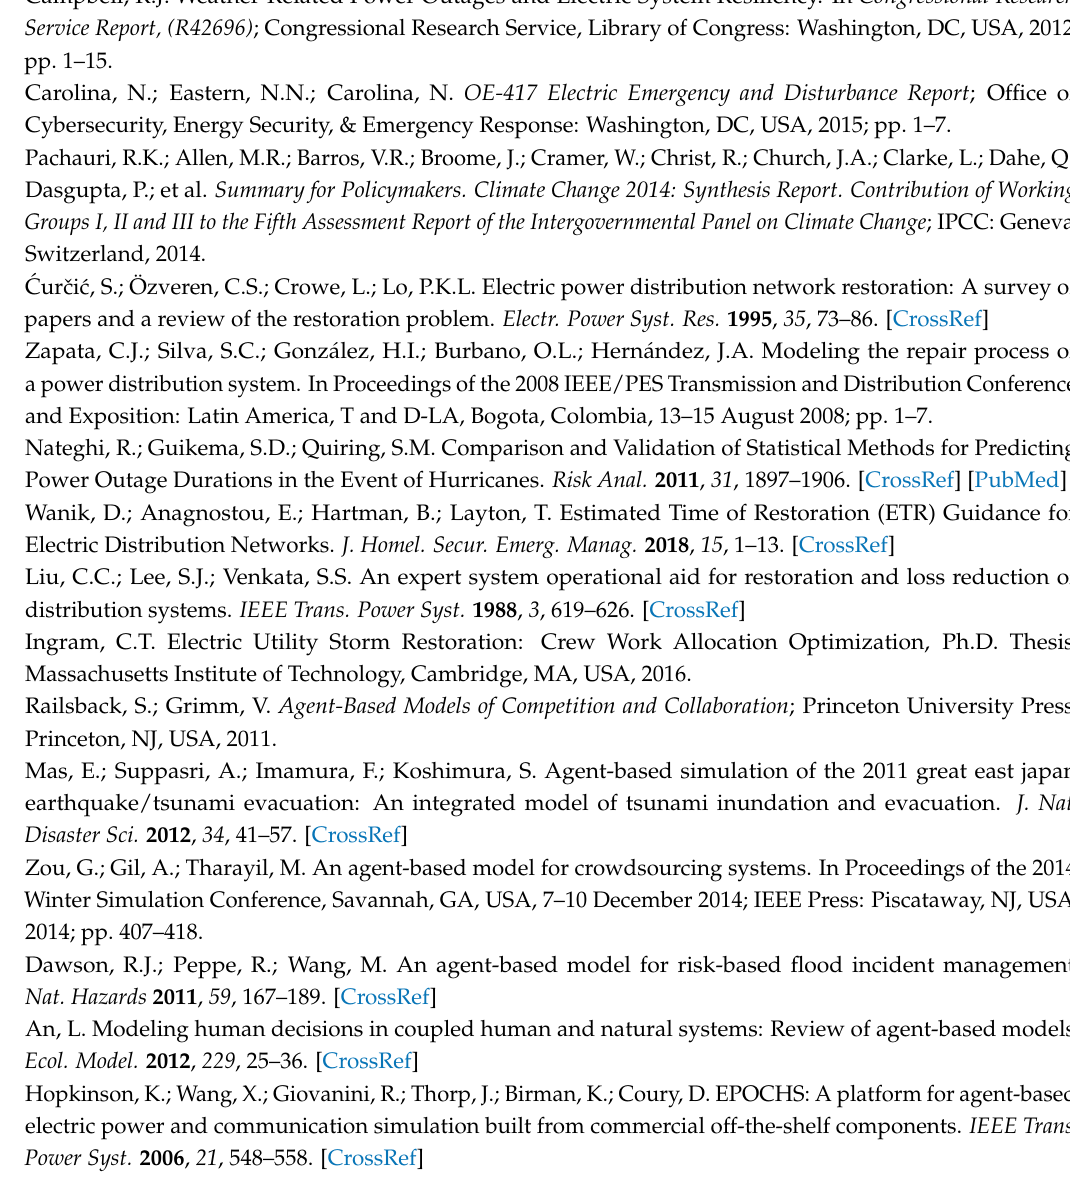
Table S1: R 2 , MAE and standard deviation of modeled restoration curves from Figure 2, Table S2. R 2 , MAE and standard deviation of modeled restoration curves from Figure 4. Figure S1: Start location of crews for small and extreme storms, Figure S2: Crew travel speeds for small storms, Figure S3: Crew travel speeds for extreme storms, Agent Based Model for Storm Recovery